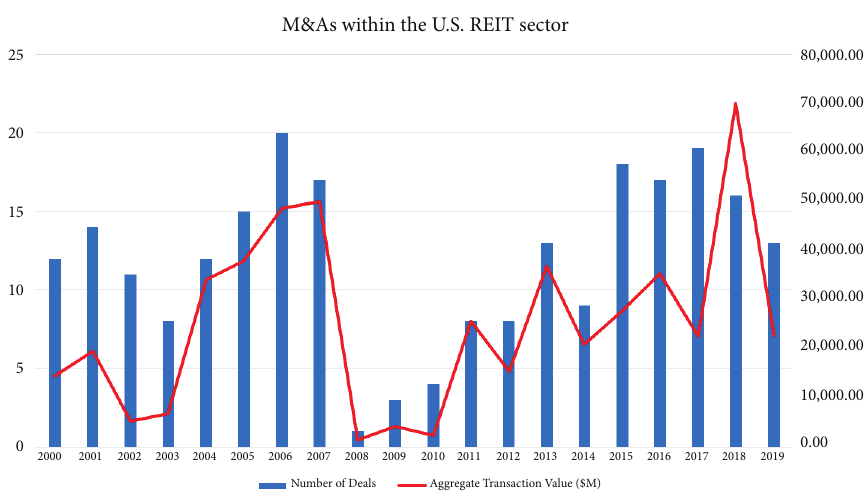
Figure 1. Number of deals and transaction value of U.S. REIT